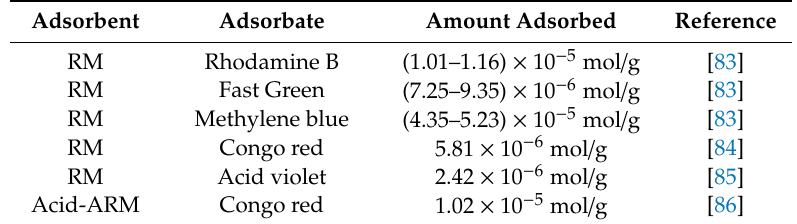
Table 5. Adsorption capacity of RM for the removal of di ff erent dyes from water [37,83–86]. Reproduced with permission from [37], published by Taylor & Francis,